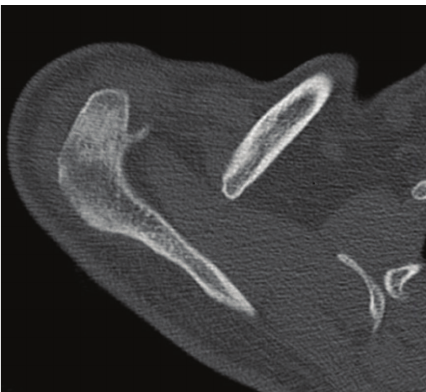
Figure 2: CT scan of the acromioclavicular joint demonstrating distal clavicle osteolysis compared to a normal joint.